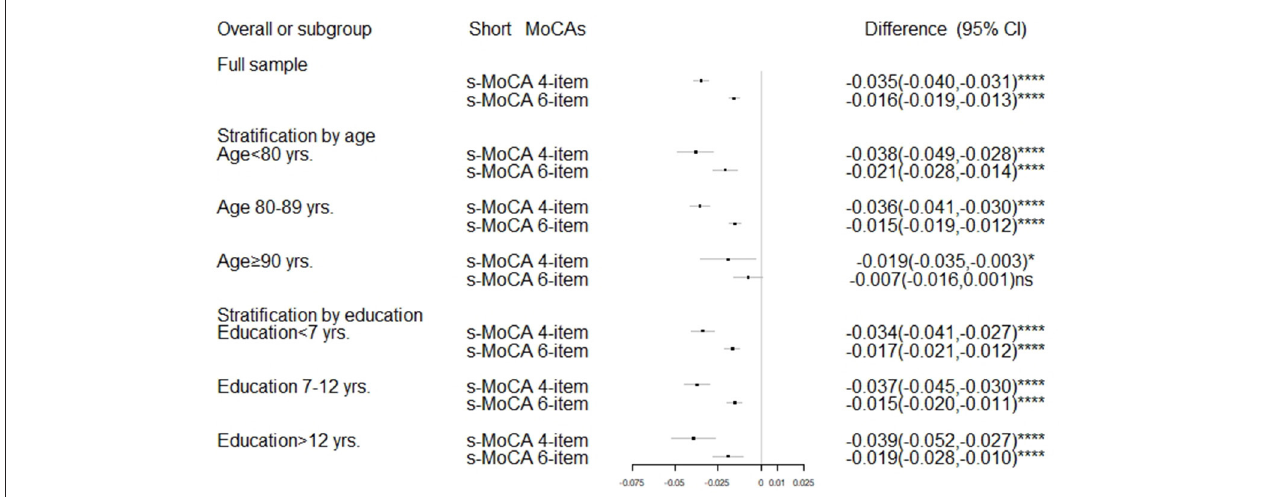
FIGURE 2 | The difference of the AUC for s-MoCA minus the AUC for MoCA. MoCA, Montreal Cognitive Assessment; s-MoCA, short form versions of the MoCA; AUC, areas under receiver operating characteristic curves; CI, confidence interval; **** p < 0.0001; * p < 0.05; ns: p > 0.05; P -value was based on the DeLong test, a method to compare two